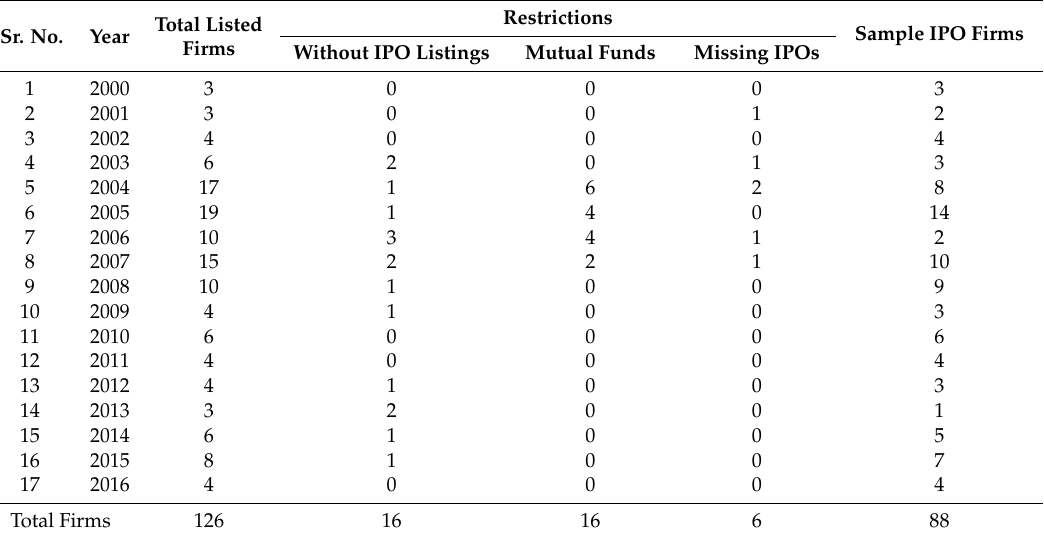
Table 1. Sample Selection Criteria and